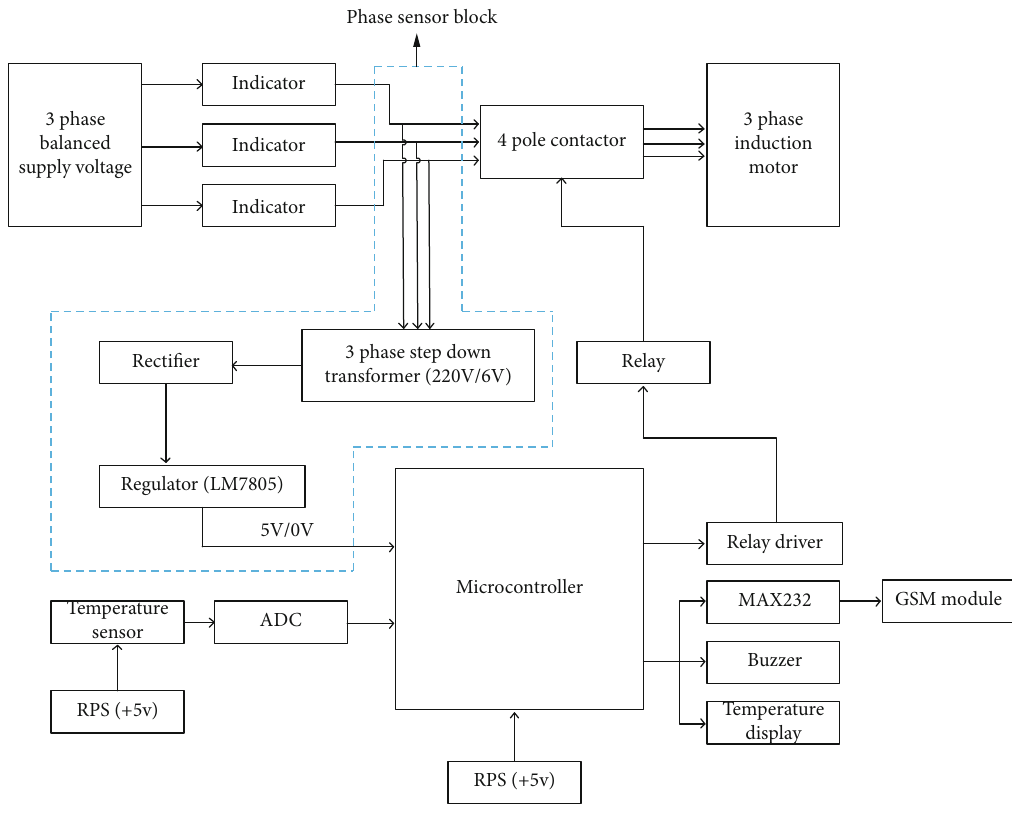
Figure 2: Block diagram of the protection